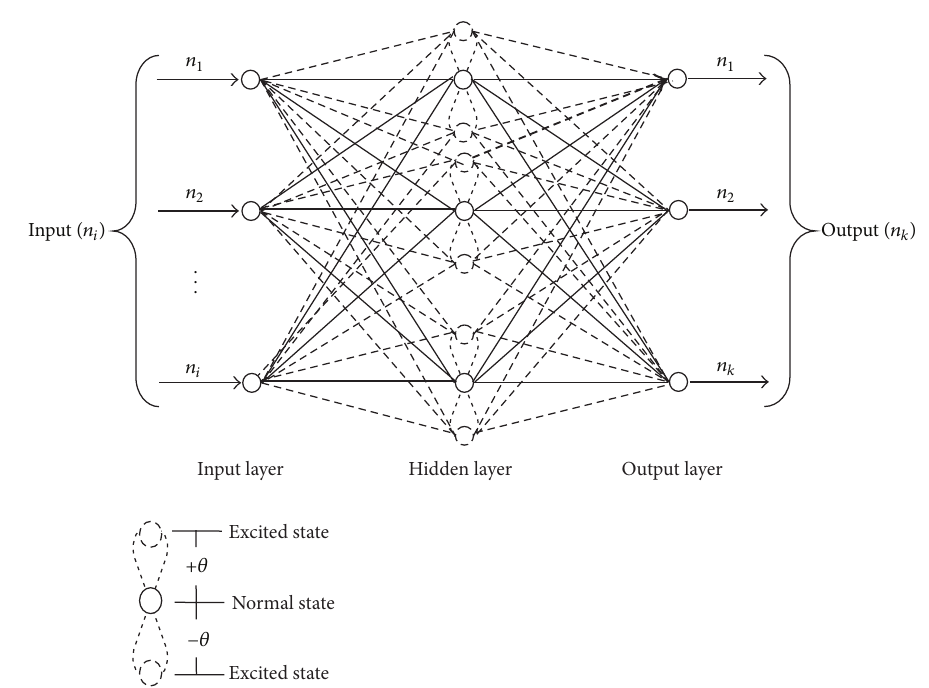
Figure 2: Architecture of Quantum Neural